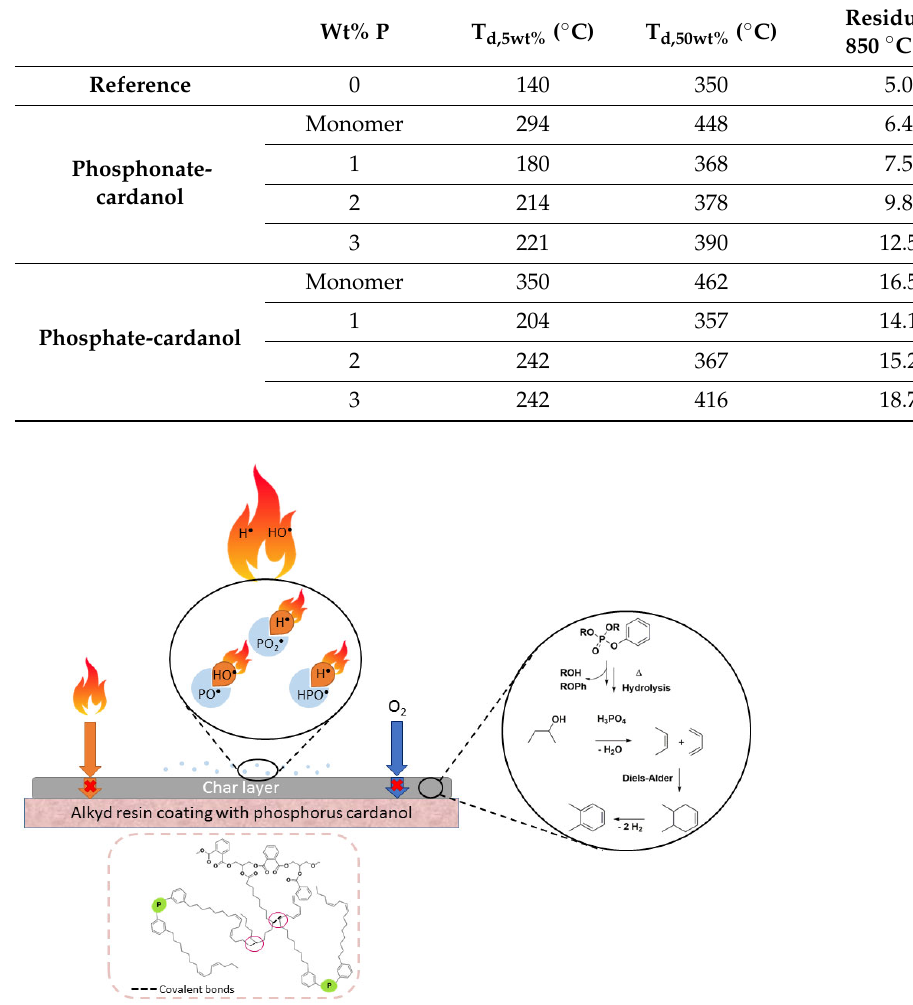
Figure 4. TGA thermograms of reference alkyd resin and phosphorylated cardanol modified alkyd resins. Table 3. Results of TGA analyses of PO x CR diluent alkyd resins.